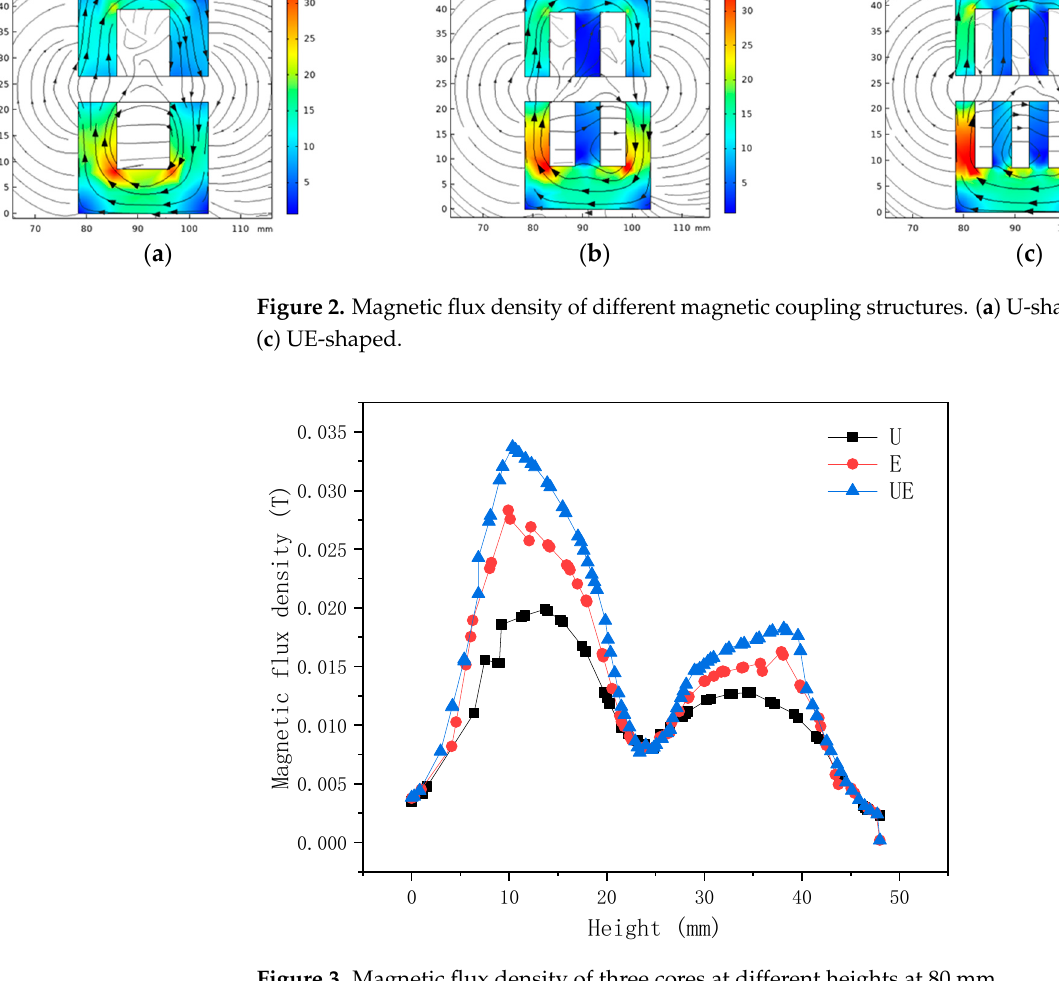
Figure 3. Magnetic flux density of three cores at different heights at 80 mm.